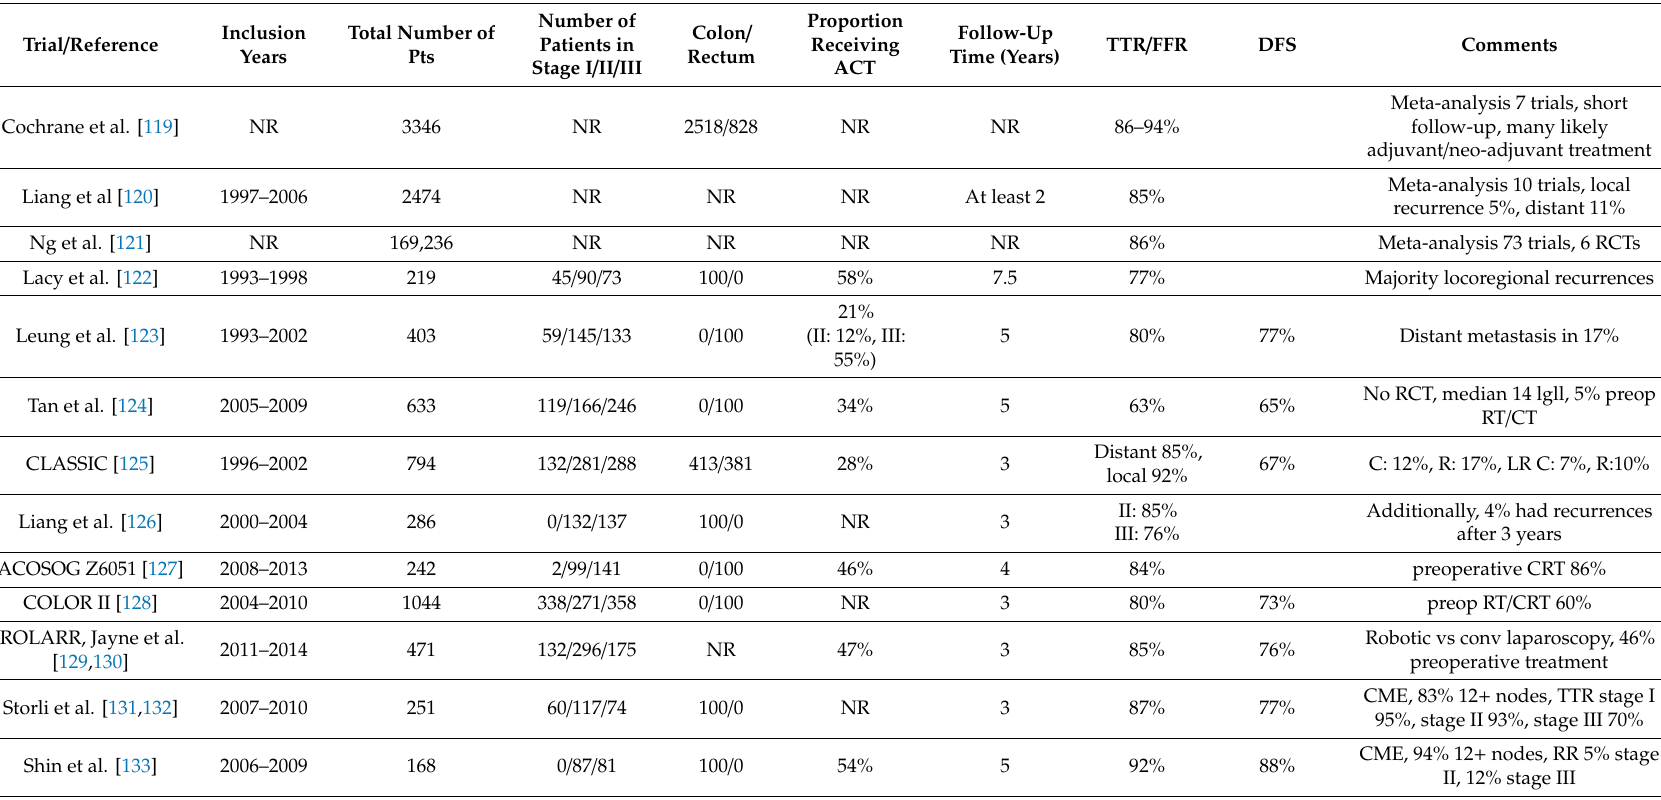
Table 5. Time to recurrence rate / freedom from recurrence and disease-free survival in studies comparing open vs laparoscopic surgery or studies where patients were operated with a circumferential mesocolic resection